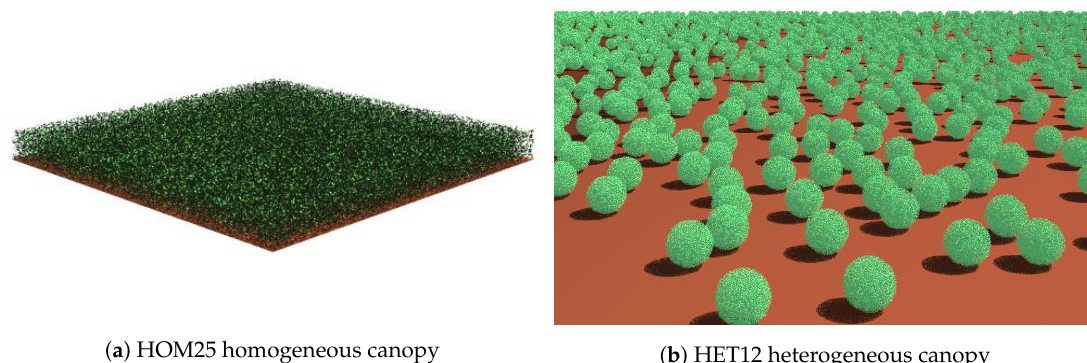
Figure 1. RAMI-IV abstract canopies used in baseline experiments for homogeneous and heterogeneous canopies.